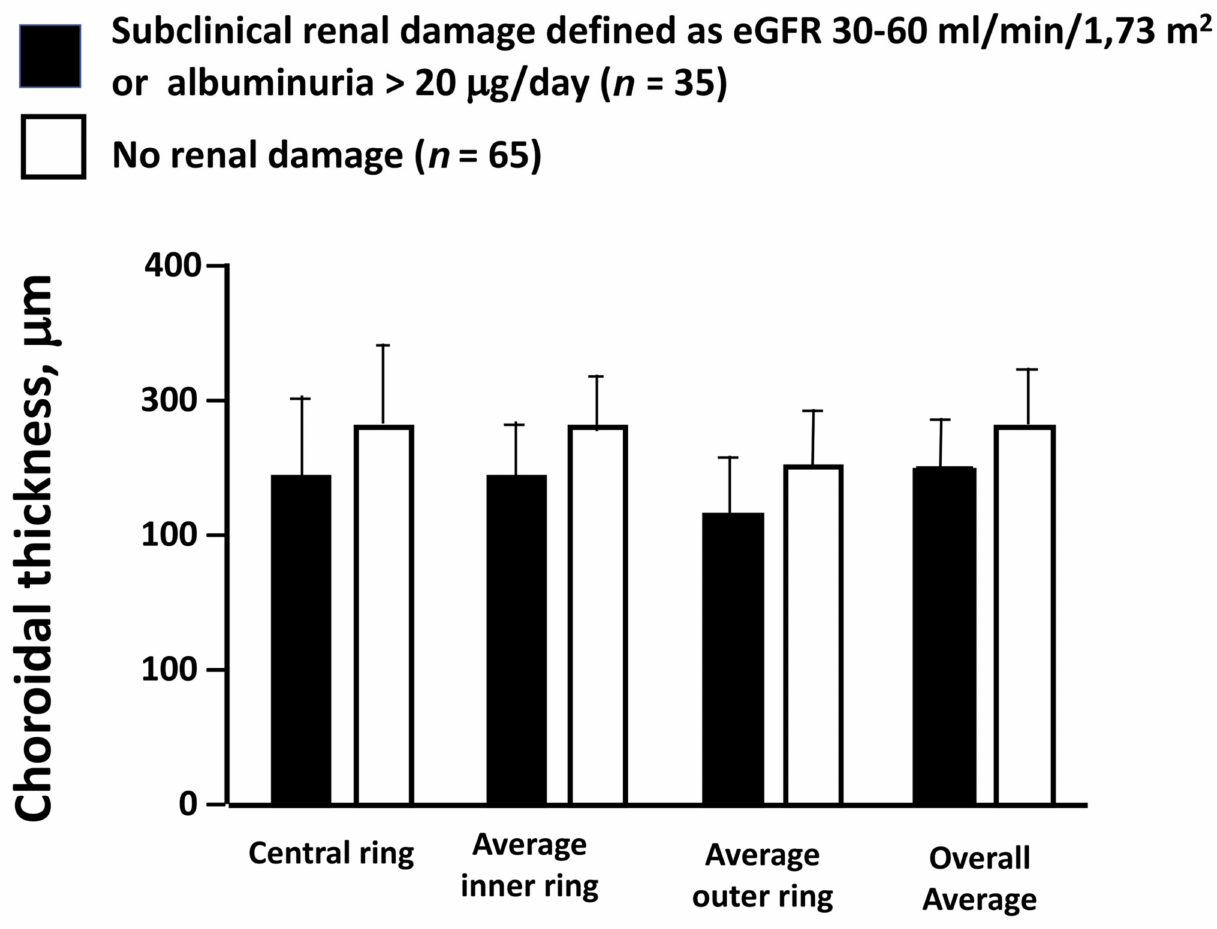
Figure 2. Mean values ± SD of ChT, measured as the overall average of all nine regions examined according to the Early Treatment Diabetic Retinopathy Study (ETDRS) protocol, and separately as the averages of the regions belonging to the inner, the outer, and the central rings. In all the comparisons, individuals with subclinical renal damage had significantly lower ChT than those with normal renal function ( p <